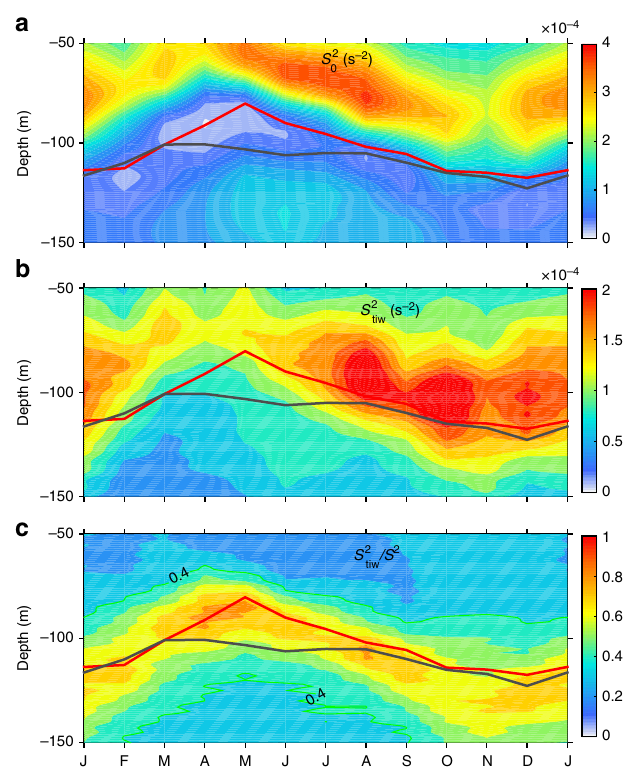
Figure 7 | Shear of background flows and TIWs. ( a ) Shear squared . ( b ) Shear squared associated with induced by the background flow, S 2 0 . ( c ) The proportion of the shear squared associated with TIWs, TIWs, S 2 tiw S 2 . In a , b and c , the red curve denotes the average depth of the EUC S 2 tiw = core and the black curve denotes the average depth of the thermocline centre. In c , contour of 0.4 is highlighted for reference. The different colour scales in a and b are